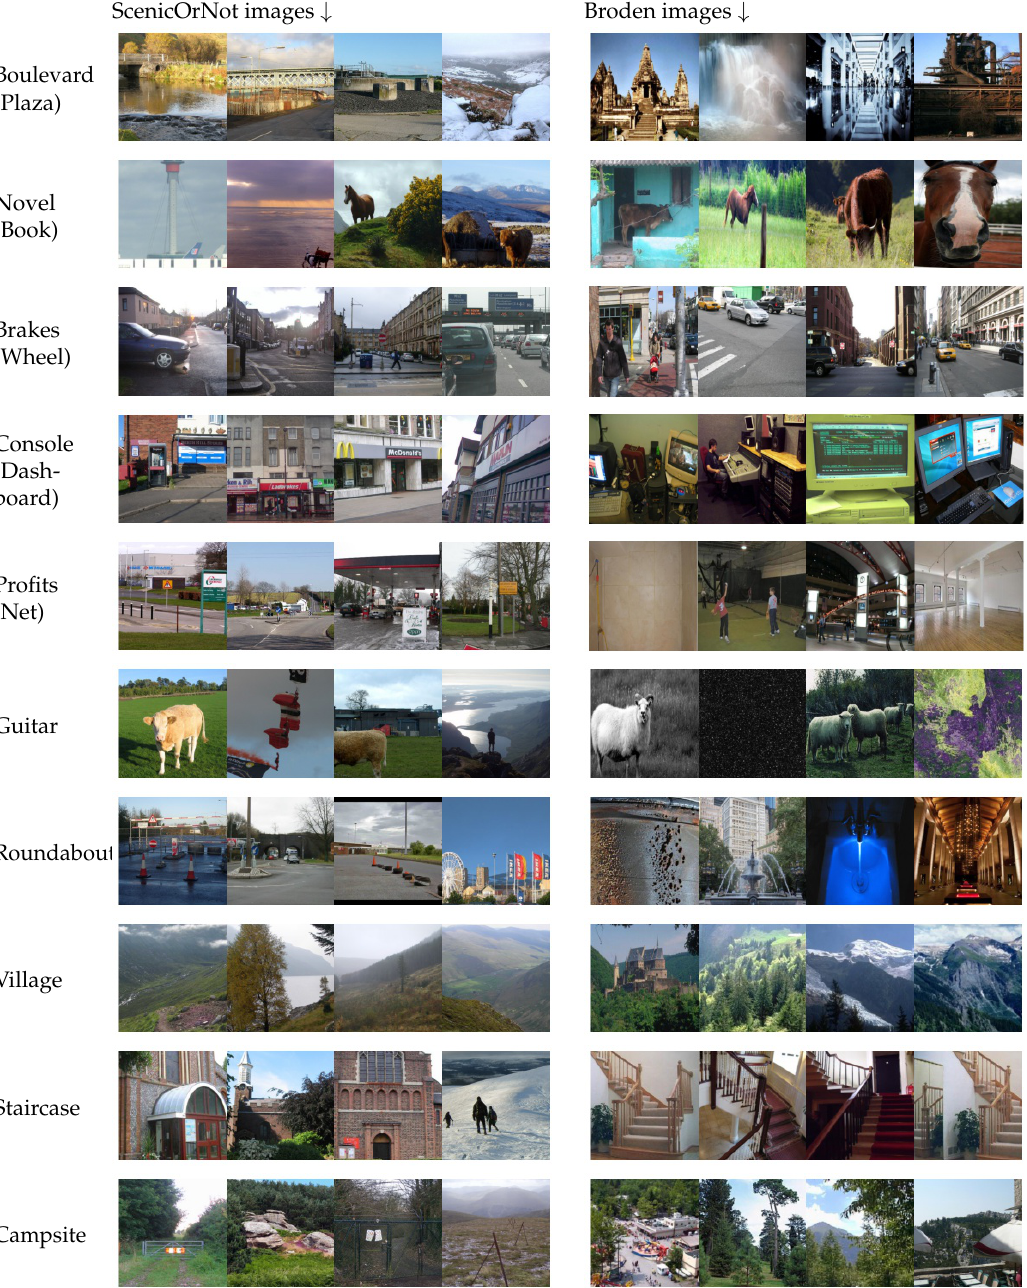
Figure 9. Examples of concepts for which the alignment resulted in inaccurate image representations. For each concept, the left images show the 4 SoN images with the highest concept score in the latent space and the images of the right show the 4 Broden images with the highest corresponding concept score in the latent space. Each concept’s training neighbor is shown between